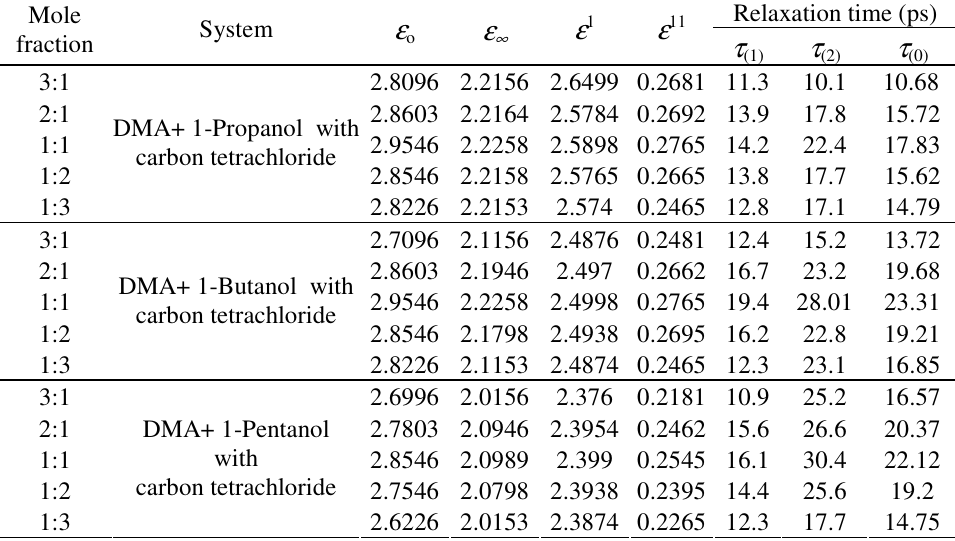
Table 1. Values of dielectric constants and relaxation time at 303 K.